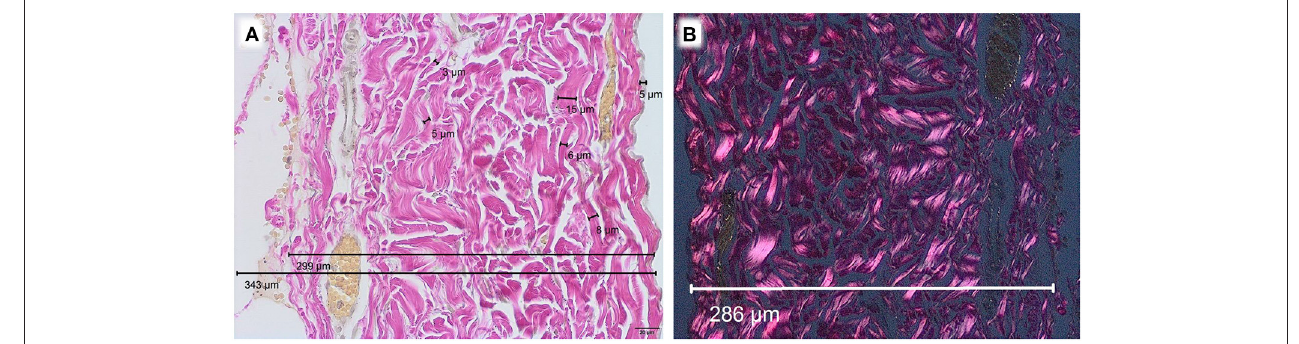
FIGURE 1 | Human pericardium of a 6-month old child, EvG staining, Obj. 40x, (A) light microscopy, (B) polarization microscopy.